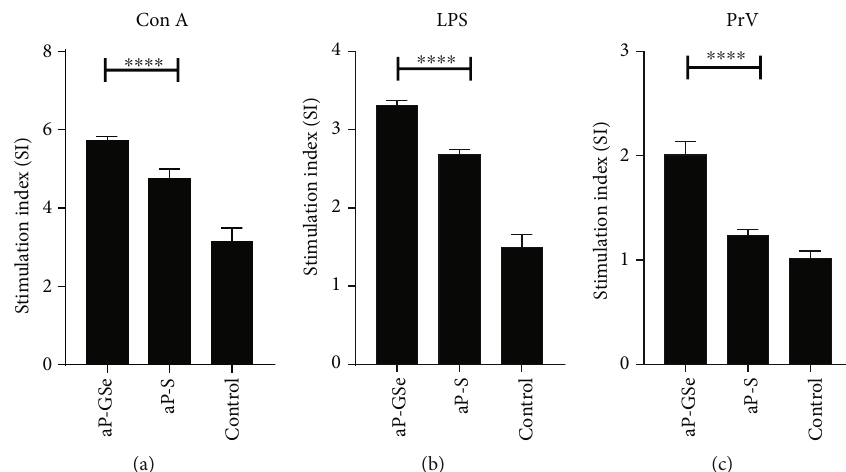
Figure 3: Lymphocyte proliferative response to Con A (a), LPS (b), and PrV antigen (c). Mice ( n = 6 /group) received twice i.m. injections of aP-GSe or aP-S at two weeks apart. Mice injected with saline were served as a control. Splenocytes were prepared 10 weeks after boost immunization and cultured with Con A, LPS, or PrV antigen for 48 h for analysis of lymphocyte proliferation using an MTT method and a stimulation index (SI) was calculated. Data are expressed as the mean ± SE . ∗∗∗∗ p < 0 : 0001 vs. aP-S group as indicated by one-way ANOVA with the LSD